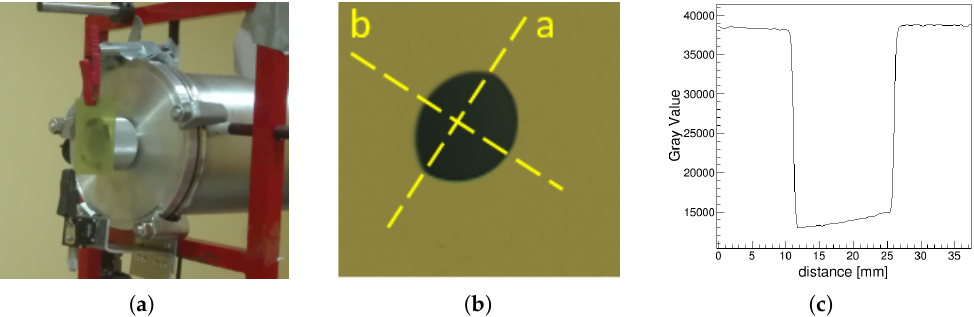
Figure 2. ( a ) EBT3 film mounted for the measurement of beam shape directly after the exit window; ( b ) EBT3 film showing beam shape; ( c ) profile of the beam taken along the “a” axis: the colour value of each pixel is plotted versus its position along the profile chosen. The lateral dimension of the beam at FWHM (Full Width at Half Maximum) is approximately equal to 15mm, which corresponds to the dimension of the graphite